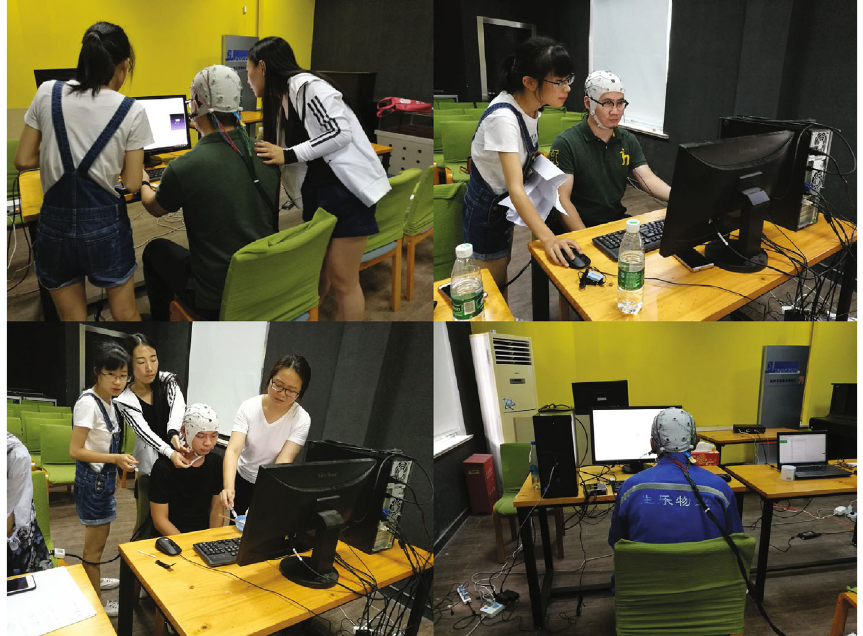
Figure 4: Experimental setup.